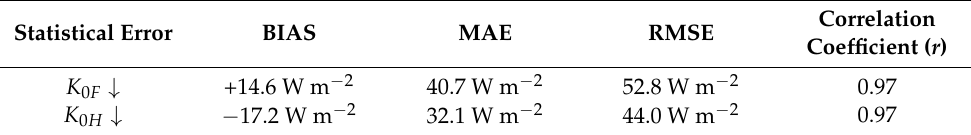
Table 3. Statistical errors for clear sky irradiance based on Foken’s and Holtslag’s separately. Statistical